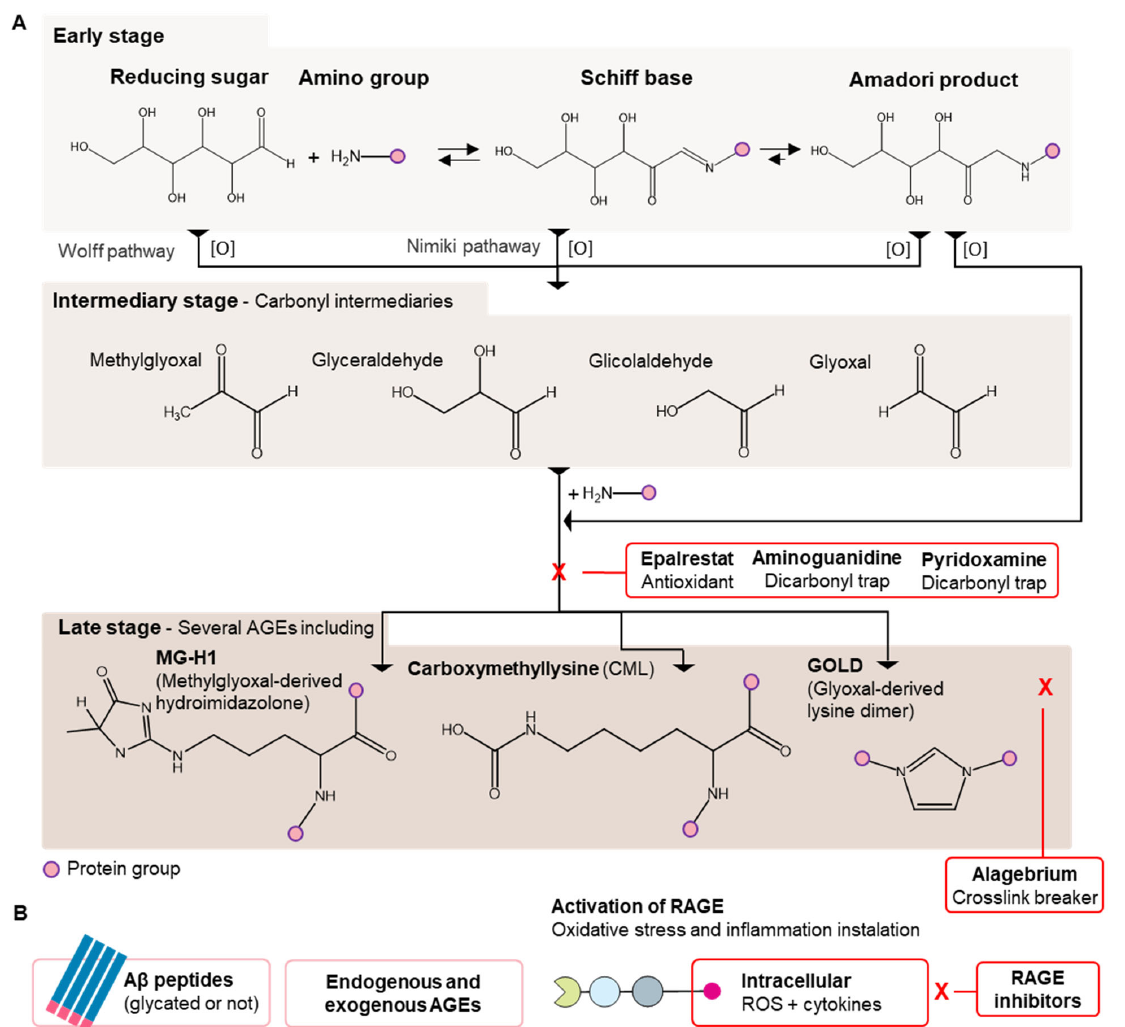
Figure 1. ( A ) Schematic representation of early stage of the Maillard Reaction and related oxidative pathways. The oxidative cleavage of Schiff base and Amadori Products results in the formation of reactive dicarbonyls. Dicarbonyls are also by-products of glucose autoxidation and glycolysis. Reactive dicarbonylic intermediaries are further involved in glycoxidation leading to the formation of AGEs [54]. Epalrestat, aminoguanidine, pyridoxamine, and alagebrium have been identified as mitigators of the Maillard Reaction, taking part in different steps. ( B ) The resulting AGEs in the latest phase of the Maillard reaction, both from endogenous and exogenous sources, have been